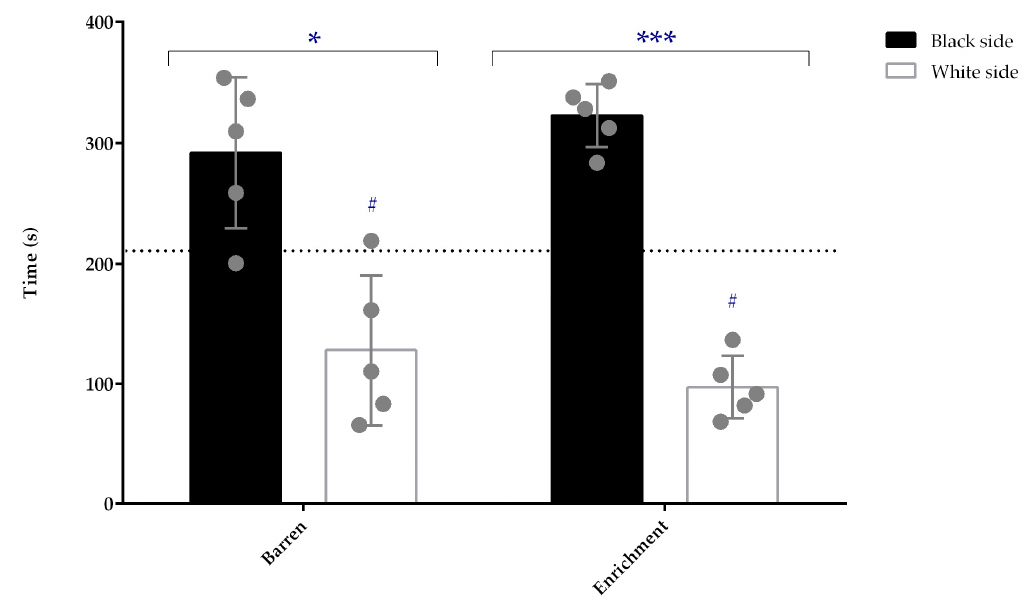
Figure 3. Time spent (s) in each side of the white/black tank by enriched and barren-housed adult zebrafish (n = 5). Data are presented as mean ± standard deviation. * p < 0.05 and *** p < 0.001 for comparisons between the white and black side of the tank for the barren and enriched-housed animals, respectively; # p < 0.05 for comparison between the time spent in the white side and the time spent there by chance (210 s). Each point represents one experimental unit, i.e., a tank.